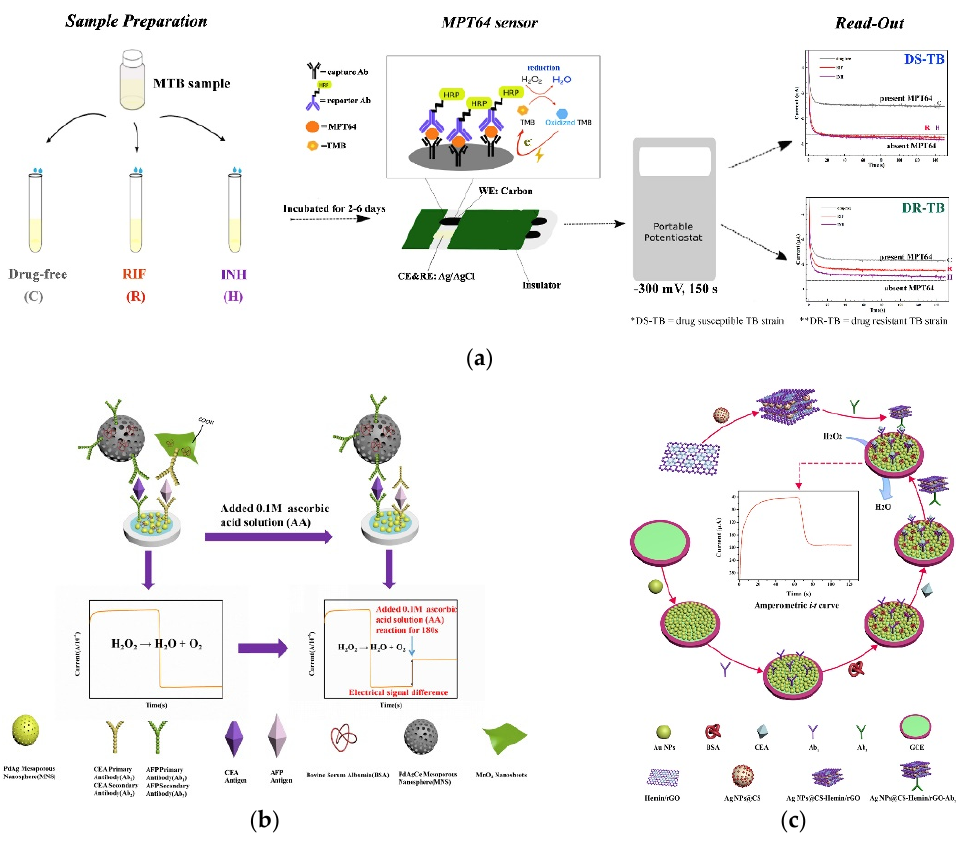
Figure 3. Examples of amperometric immunosensors with non-covalently immobilized antibodies. ( a ) Sandwich amperometric immunosensor. The immunoaffinity layer was fabricated by the direct treatment of antibodies on the electrode. Reproduced with permission [53]. Copyright (2018) Elsevier. ( b ) Composites-based immunosensor. Antibodies were immobilized on the PdAg nanosphere-modified electrode by physical adsorption. Reproduced with permission [55]. Copyright (2020) Elsevier. ( c ) AuNP-based immunosensor. An immunoaffinity layer was formed by immobilizing antibodies on the AuNP-coated electrode. Reproduced with permission [57]. Copyright (2020) Elsevier.